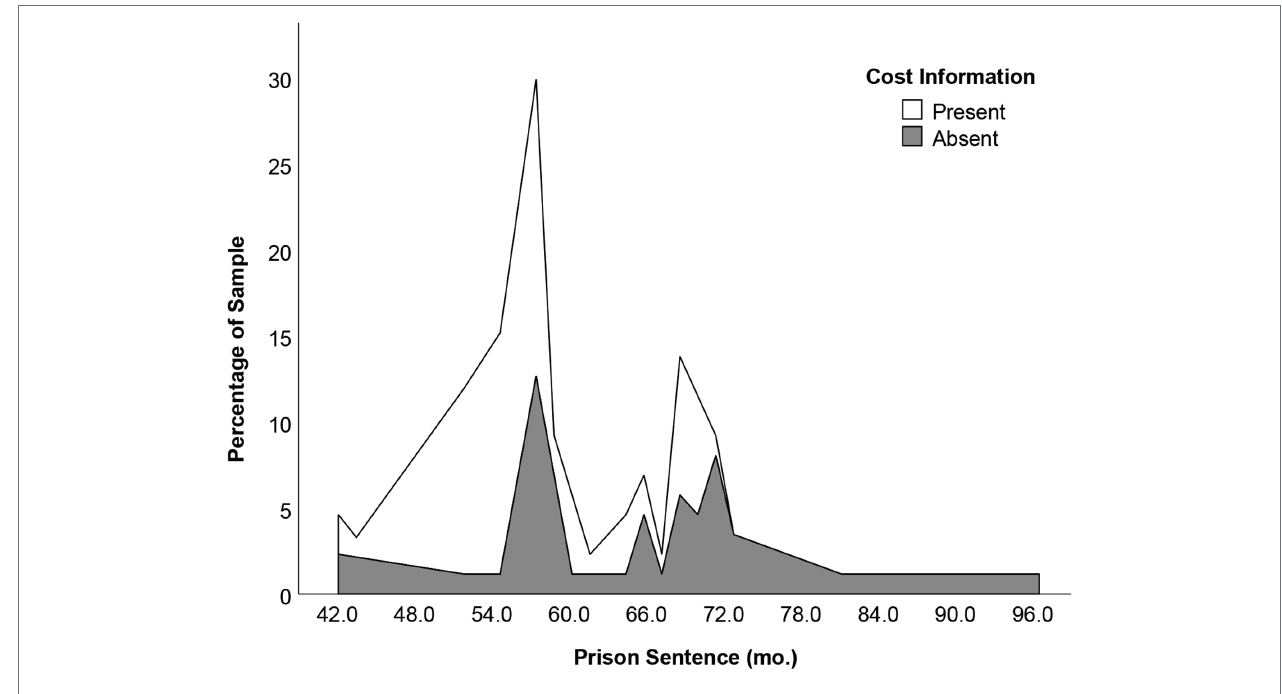
FIGURE 1 | Histogram of prison sentences colored by cost information (present vs. absent), interpolated across 43 bins. Plot shows a disproportionate representation of sentences from the present condition on the lower end of the sentencing scale. Y-axis represents the percentage of total number of